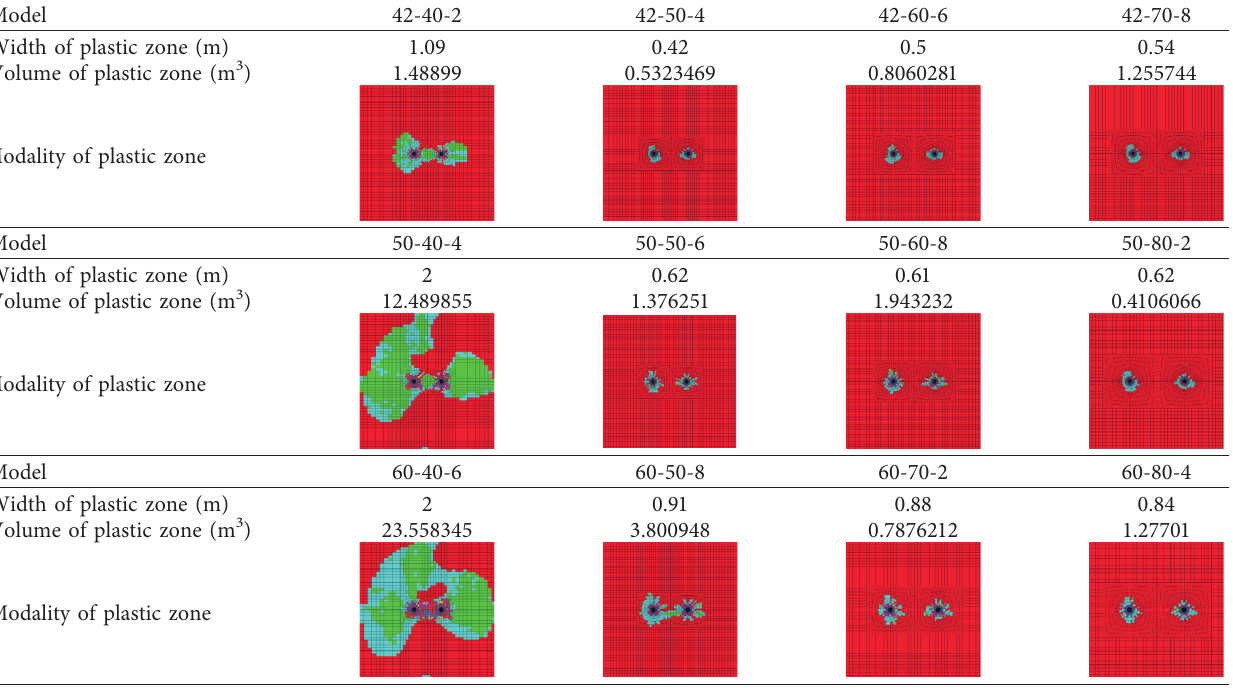
Table 6: Distribution of plastic zones.